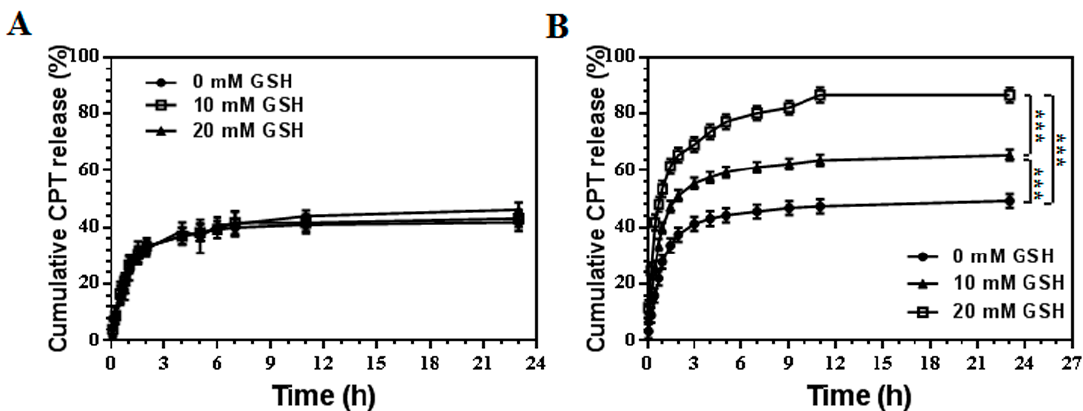
Figure 3. In vitro release kinetics of camptothecin (CPT) from ( A ) CPT-NCs-A and ( B ) CPT-NCs-B in a phosphate-buffered saline (PBS) buffer at a pH = 7.4 at different glutathione (GSH) concentrations. Data represent means ± SD ( n = 3), and *** p < 0.001.